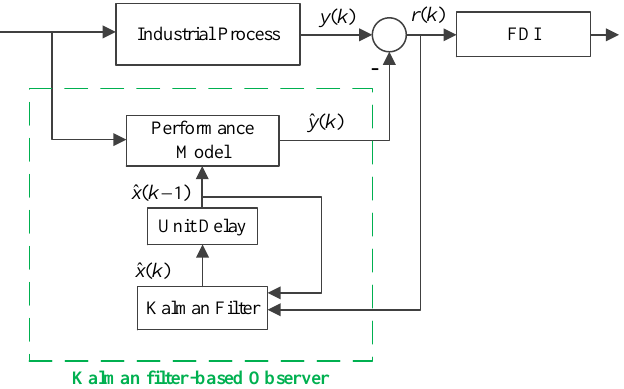
Figure 9. General structure of Kalman filter-based fault detection